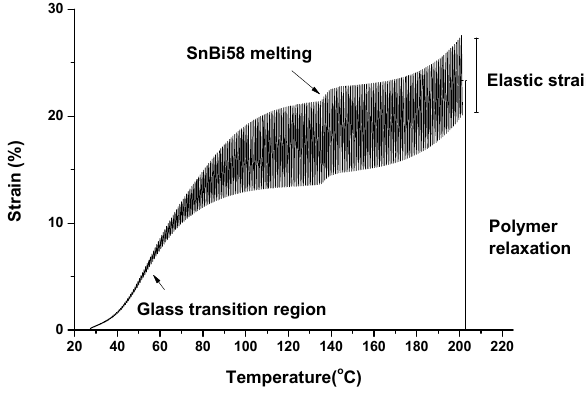
Figure 15. Strain of acrylic based SnBi58 solder ACFs in respect to a sinusoidal load in DMA as a function of temperature.